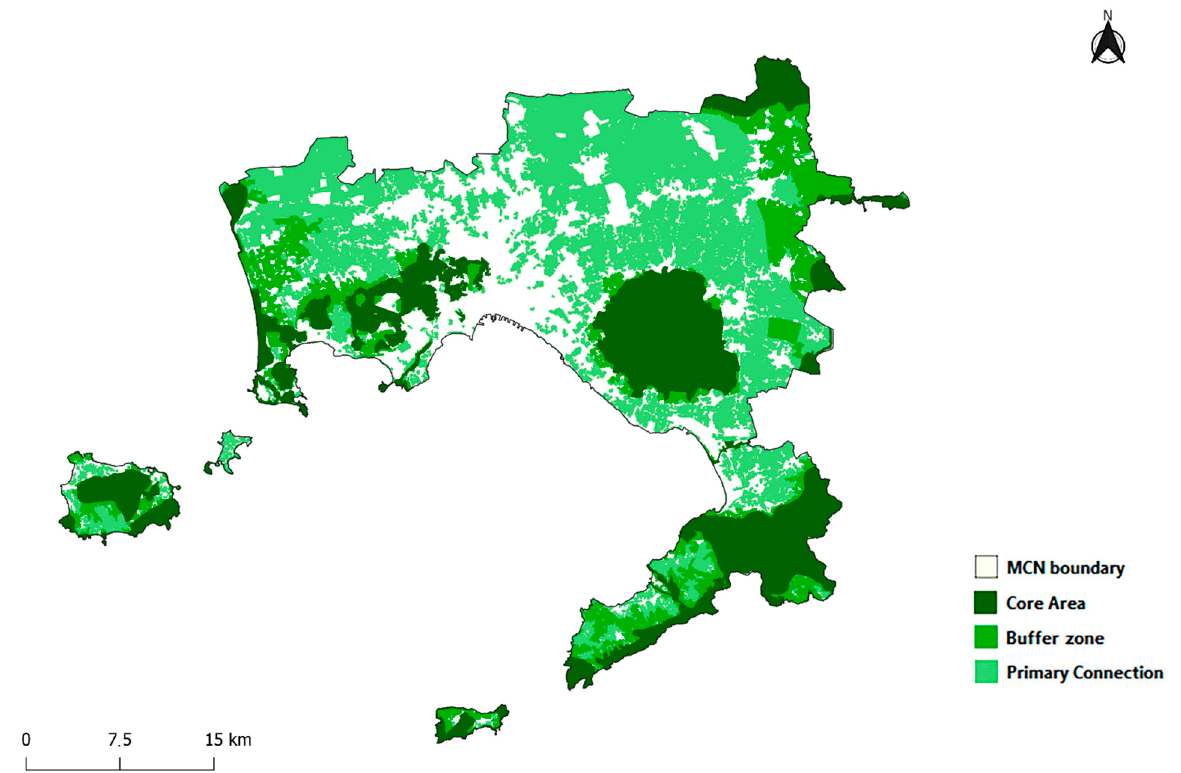
Figure 5. Map of the Metropolitan City of Naples (MCN)’s ecological network, representing the spatial relationships between Core Areas, Buffer Zones, and Primary Connections.